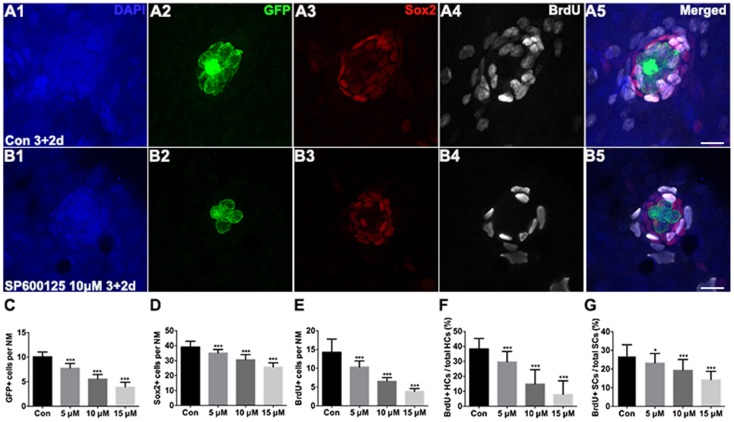
Detection of neuromast hair cells and supporting cells in 5 dpf larvae. (A,B) Confocal images of neuromasts from a 5 dpf control larva and 5 dpf larva treated with 10 μM SP600125. The neuromast hair cells in the transgenic line Brn3c:mGFP were detected by GFP visualization (green), supporting cells were detected by Sox2 (red), and proliferating cells were detected by BrdU (white). Higher magnification of hair cells and supporting cells of the neuromast taken from z-stacks show that hair cells and supporting cells in untreated controls and SP600125-treated animals had no observable morphological differences though there were fewer GFP-positive and Sox2-positive cells in the neuromasts of larvae treated with SP600125. The number of BrdU-labeled cells is much larger in control than in SP600125-treated larvae. Scale bar = 10 μm. (C,D) Quantification of hair cells and supporting cells in the neuromast (NM) for each experimental condition. (E–G) Quantification of replicating cells in the neuromasts for each experimental condition. SP600125 treatment decreased the numbers of BrdU-positive cells, the ratio of BrdU-positive hair cells, and the ratio of BrdU-positive supporting cells in neuromasts. The first four neuromasts along the body, L1–L4, were recorded on one side of each fish [one-way ANOVA; GFP+ cells: F(3, 112) = 237.5, p < 0.001; Sox2+ cells: F(3, 112) = 102.5, p < 0.001; BrdU+ cells: F(3, 112) = 134, p < 0.001; BrdU+ HCs: F(3, 112) = 89.7, p < 0.001; BrdU+ SCs: F(3, 111) = 32.08, p < 0.001]. Bars are mean ± SD. n = 36 neuromasts in control, n = 28 in 5 μM SP600125-treated neuromasts, n = 24 in 10 μM SP600125-treated neuromasts, and n = 28 in 15 μM SP600125-treated neuromasts. *p < 0.05, significant difference when compared to control larvae; ***p < 0.001, highly significant difference when compared to control larvae.